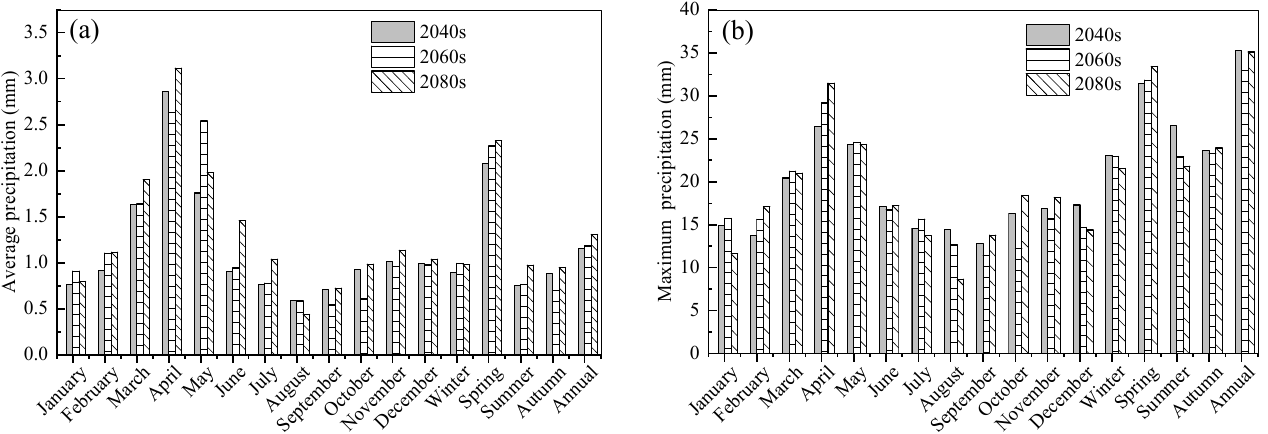
Figure 8. The projected ( a ) mean precipitation and ( b ) maximum precipitation for the 2040s, 2060s, and 2080s scenarios.